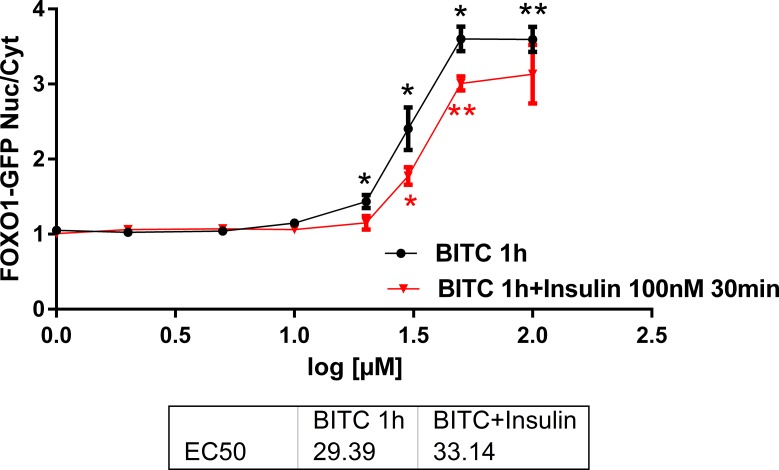
U-2 OS-FOXO1-GFP cells treated with BITC 1–100 μM for 1h and addition of 100 nM insulin after 30 min.The curves show the relative nuclei/cytoplasm intensity of FOXO1-GFP for BITC without (black curve) and with insulin addition (red curve). Results are presented as mean values + standard error (SEM) (n = 4). Significant differences vs control (0 μM) are labelled for *(p<0.05) and **(p<0.01) (Oneway ANOVA and posthoc Dunnett T3).